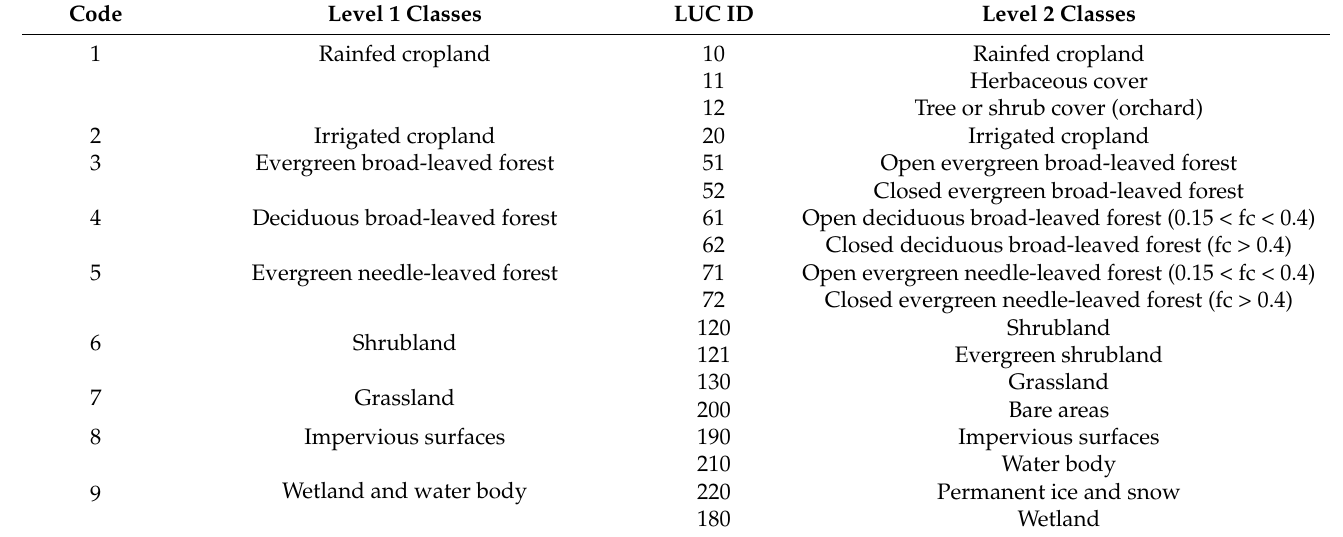
Table 1. LUC classification system in Laos.